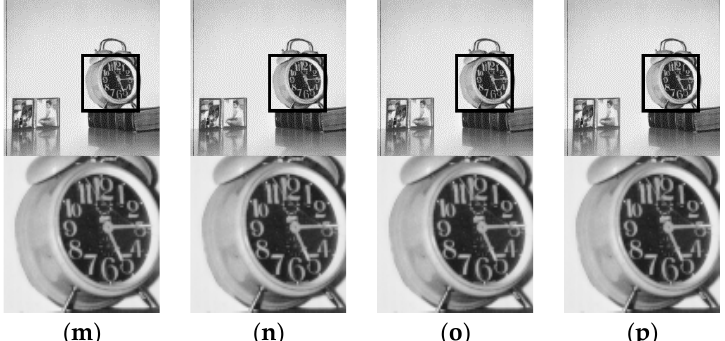
Figure 11. Visual analysis of the grayscale images recovered from the CPE processing. ( a ) The original image. ( b – d ) Cipher images obtained from the GS–CPE, GS–IIB–CPE (4 × 4), and GS–IIB–CPE (2 × 2) methods, respectively. The images recovered were compressed with the JPEG 𝑞𝑓 = 71 in ( e – h ), 𝑞𝑓 = 85 in ( i – l ), and 𝑞𝑓 = 100 in ( m – p ). For each image, the boxed region is zoomed in and shown below them.